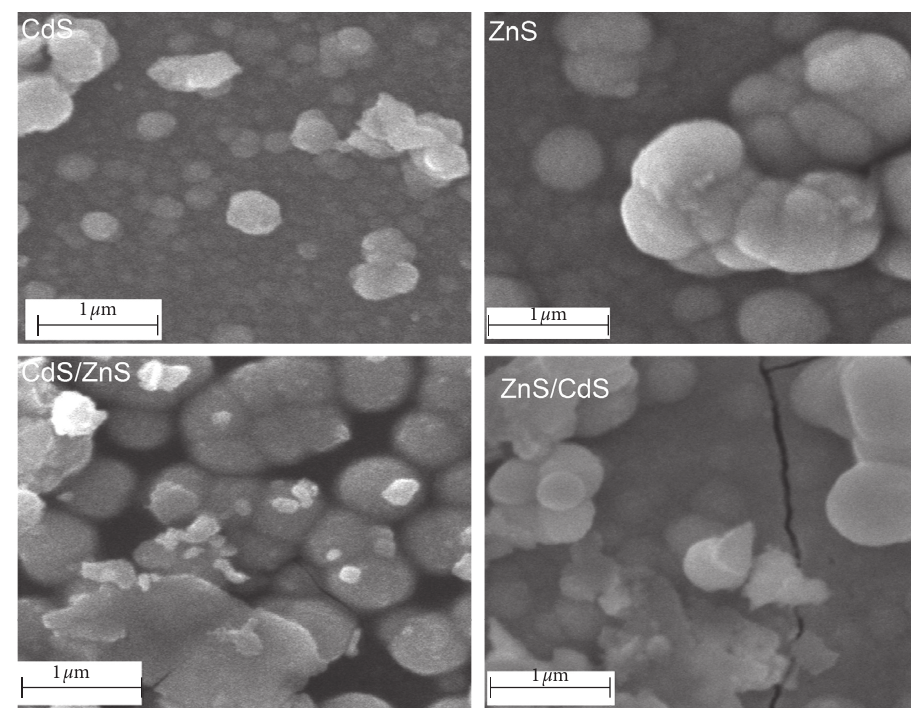
Figure 6: Surface morphology of single and multilayers of CdS and ZnS thin films.